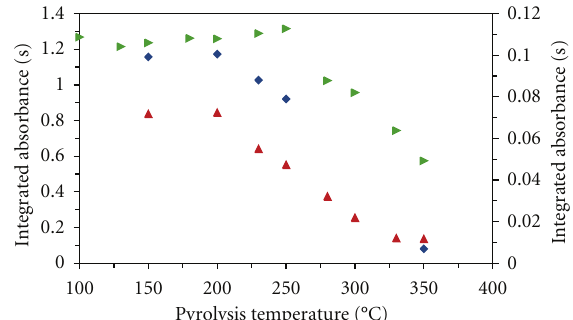
Figure 2: Pyrolytic curves for Hg(II) solutions in the presence of stabilizing agents and Pd surface modifier. left axis: (cid:2) DEDTC, (cid:3) TMDTC; right axis: (cid:4) without stabilizing agent.